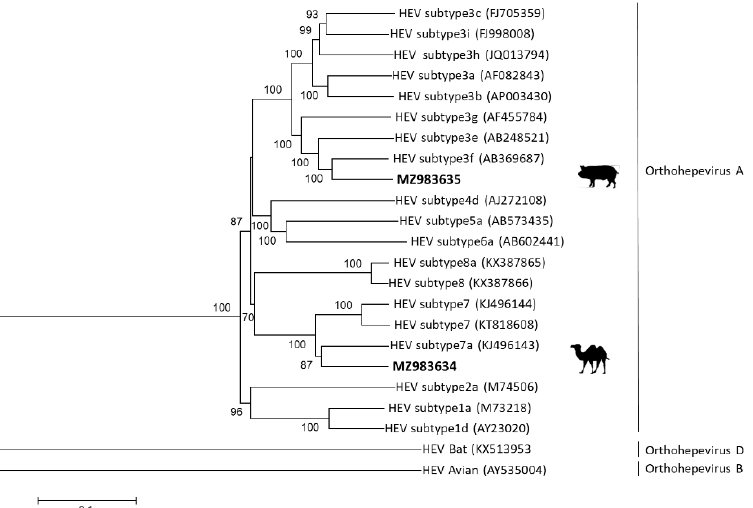
Figure 1. Phylogenetic tree of local HEV from camel and from swine. The tree was constructed using the maximum likelihood method with MEGA7. Bootstrap values of >70% are presented. The analysis included the whole genomes of GenBank HEV reference sequences (HEV-1-8), shown in parentheses. The GeneBank assignment for local camel HEV-7 is MZ983634 and for local swine HEV-3f is MZ983635.